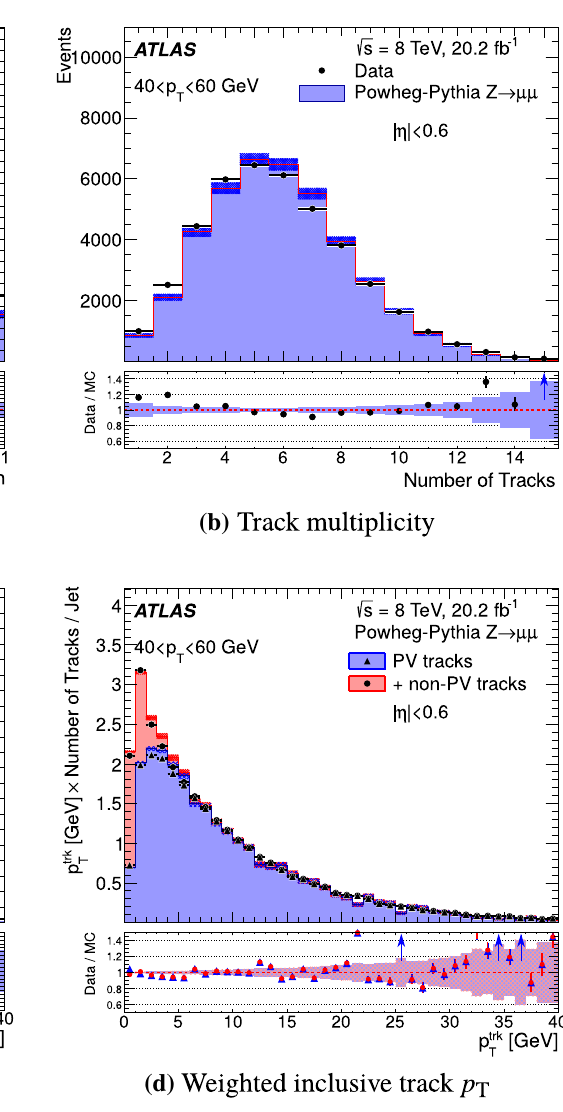
weighted by the track p T and normalised to the number of jets, illustrat- ing the transverse momentum flow from particles of different p T . The distribution is shown both for tracks satisfying the hard-scatter primary vertex association criteria and forming the jet as well as the additional tracks within (cid:8) R = 0 . 4 of the jet failing to satisfy the hard-scatter primary vertex association criteria. The darker shaded bands represent the statistical uncertainties